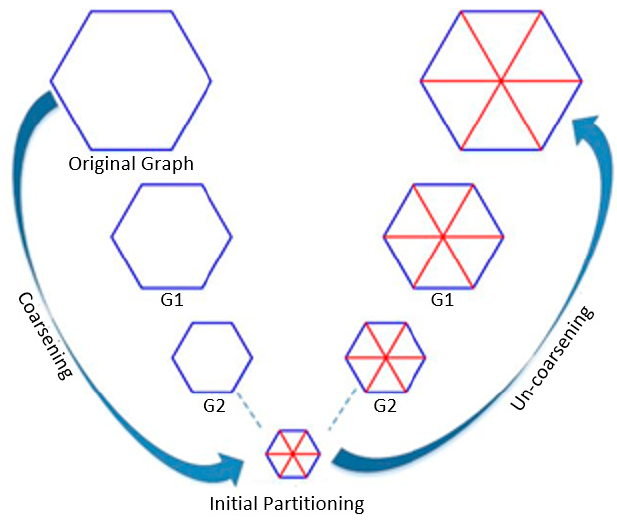
Figure 3. Multilevel k-way partitioning graph algorithm steps.